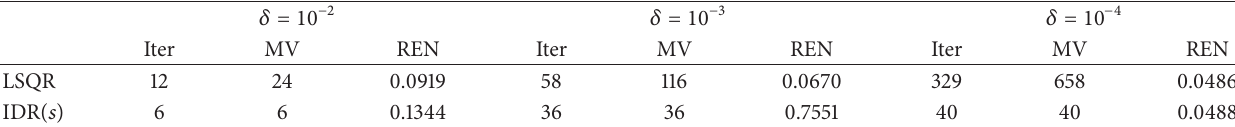
Table 2: Image deblurring using LSQR and IDR( 𝑠 ) for “Lena” ( 𝜎 = 1.5